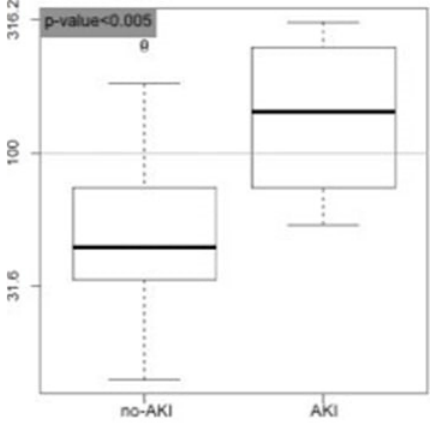
Figure 5. PenKid concentrations expressed in pmol/L. Box plots. No-AKI: distribution of the penKid values of the patients who did not develop AKI ( n = 149, median = 44.3); AKI: distribution of the penKid values of the patients who developed AKI ( n = 4, median = 151.1).